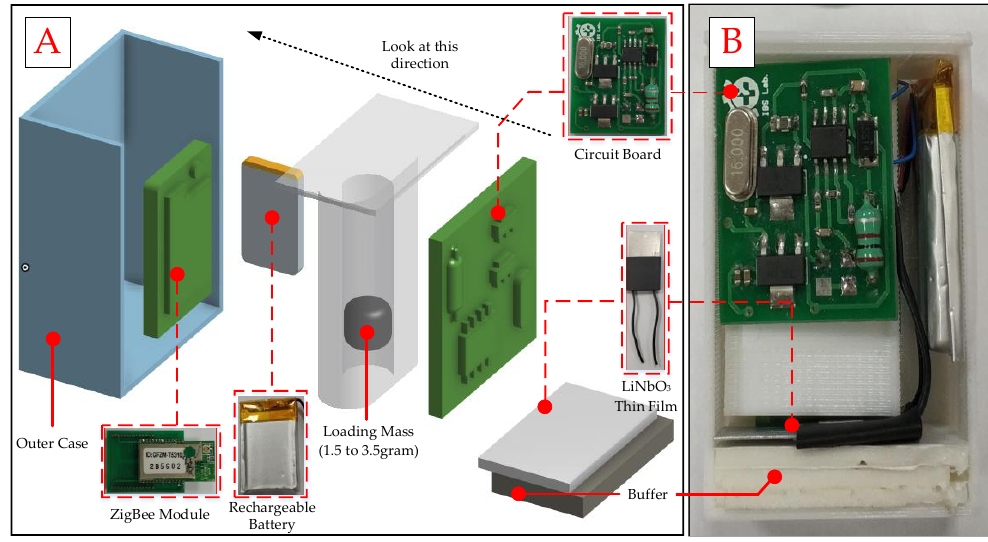
Figure 6. ( A ) The Photograph of SN design and ( B ) the picture of device.